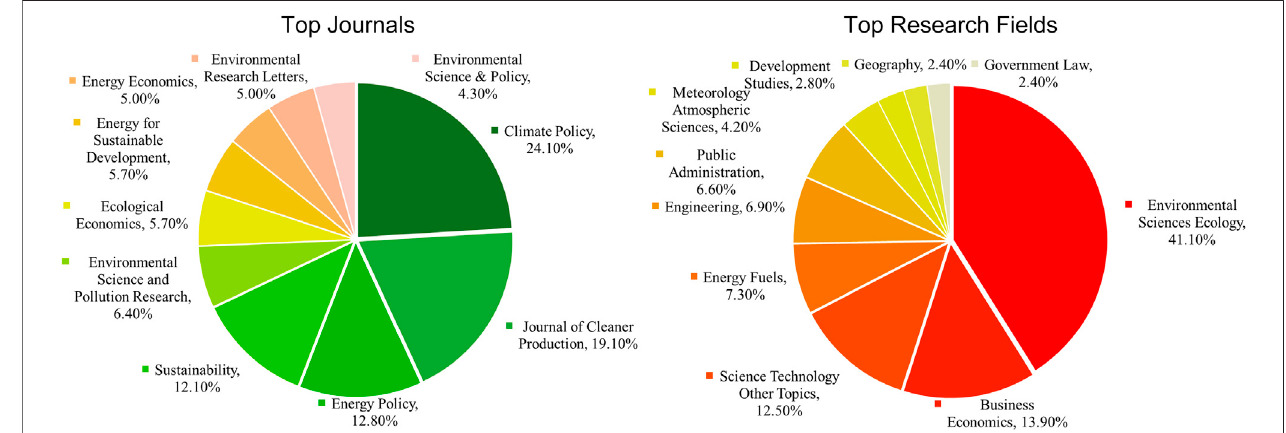
FIGURE 6 | Productive journals and research fi elds. A single article can be categorized under several research directions.